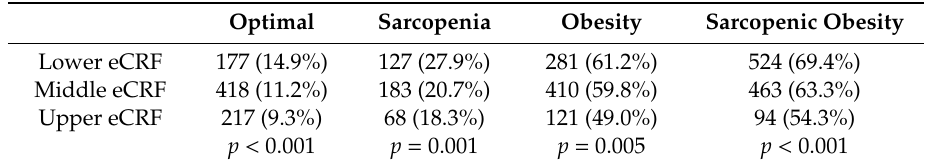
eCRF: non-exercise-based estimation of cardiorespiratory fitness.